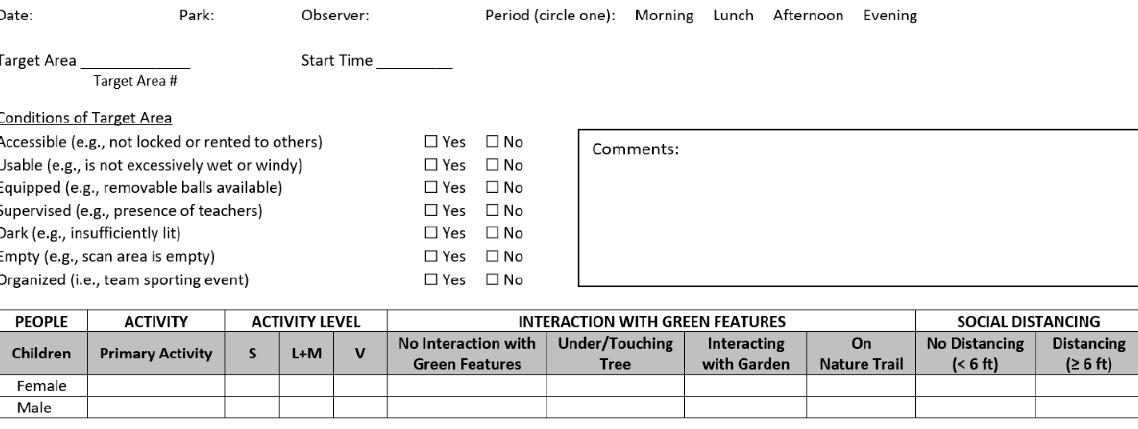
Figure A2. System for Observing Play and Recreation in Communities (SOPARC) data collection form.